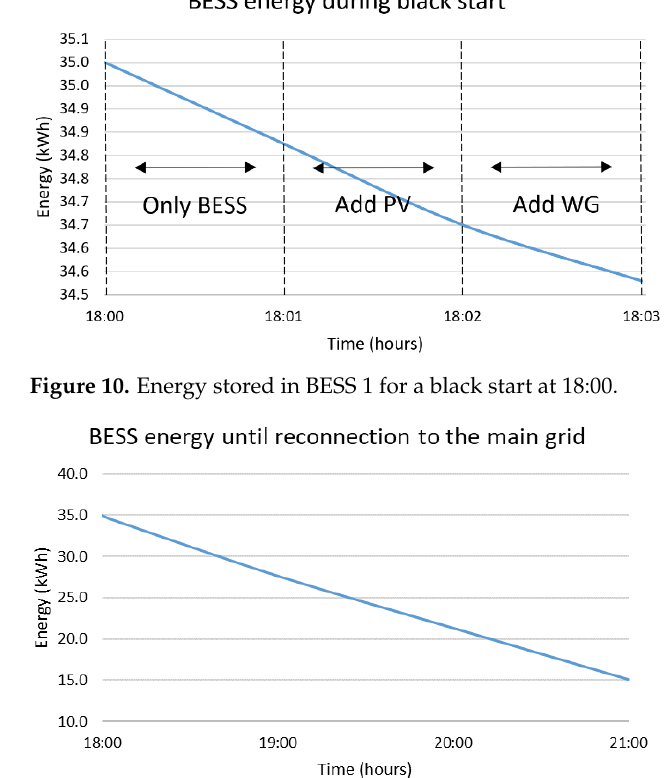
Figure 11. Energy stored in BESS 1 for a black start at 18:00 followed by islanded operation until 21:00.